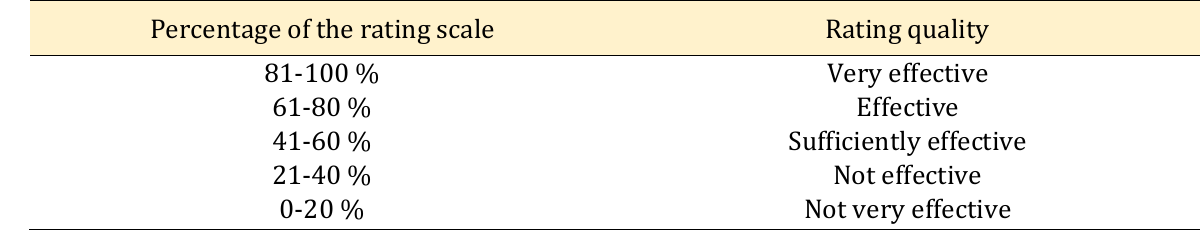
Table 1: The Interpretation of the Effectiveness